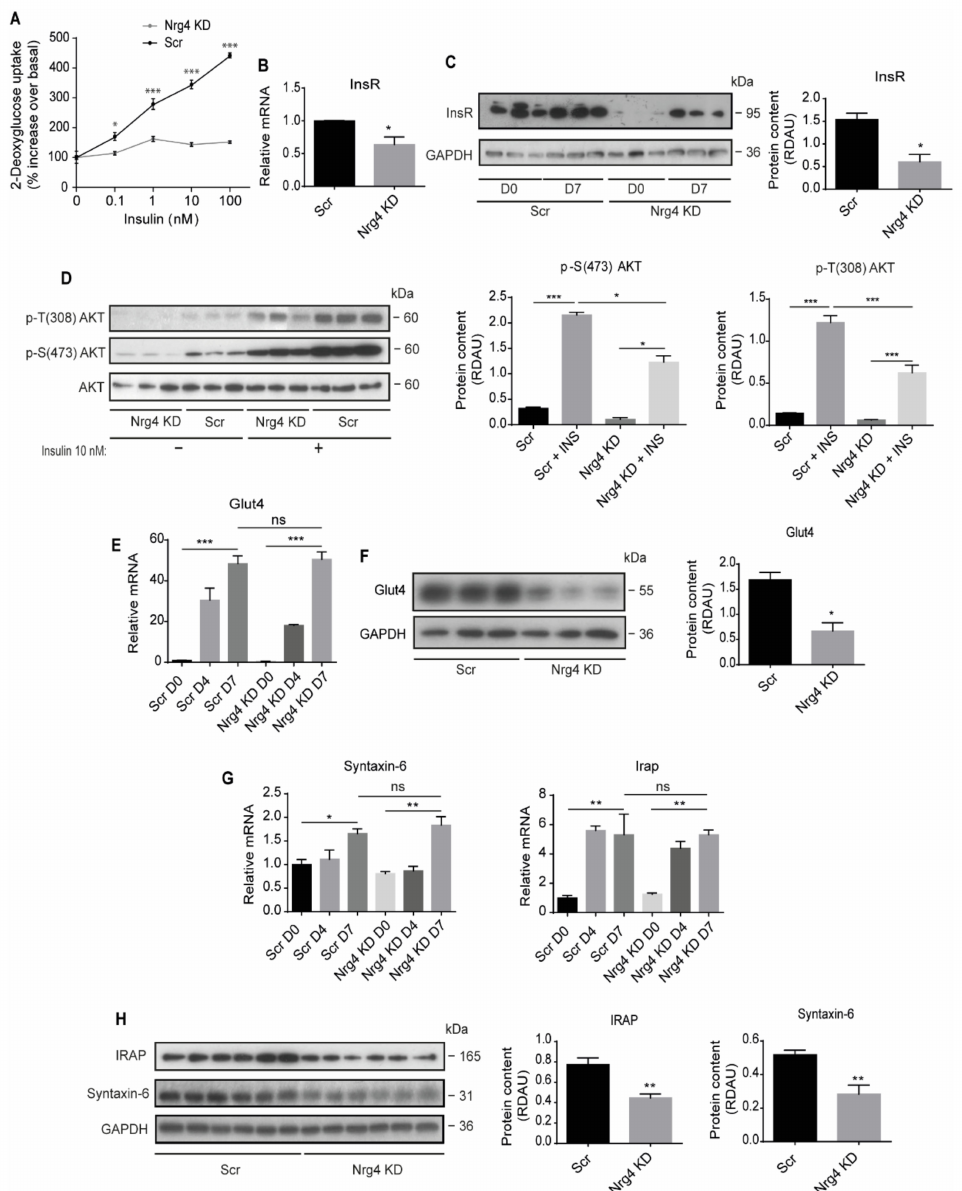
Figure 2. Nrg4 knockdown adipocytes are insulin resistant and show diminished insulin receptor expression and Glut4 protein content. ( A ) Concentration-response curve of the effect of insulin on 2- D -deoxyglucose uptake in Scr and Nrg4 KD adipocytes at day 7 (D7) of differentiation ( n = 3). Cells were starved without fetal bovine serum for 16 h and then incubated with different insulin concentrations for 30 min. 2- D -deoxyglucose uptake data were expressed as the % increase relative to basal values, in nmols/mg protein × 5 min. ( B ) Insulin receptor (InsR) expression in D7 Scr and Nrg4 KD adipocytes ( n = 3). Data were normalized to Scr adipocytes D7 expression. ( C ) Western blot bands of InsR β subunit in Scr and Nrg4 KD cells at D0 and D7 ( n = 3). The lower band of the InsR β subunit blot at D7 was quantified. ( D ) Western blot bands and quantification of phospho (p)-T(308)AKT and p-S(473)AKT in insulin-treated and non-treated Scr and Nrg4 KD adipocytes at D7 ( n = 3). Data were normalized to AKT protein content. ( E ) Glut4 expression in Scr and Nrg4 KD cells at D0, D4 and D7 ( n = 6). Data were normalized to Scr D0 preadipocyte expression. ( F ) Western blot bands and quantification for Glut4 in Scr and Nrg4 KD cells at D7 ( n = 3). ( G ) Syntaxin-6 and Insulin-regulated aminopeptidase (Irap) expression in Scr and Nrg4 KD cells at D0, D4 and D7 ( n = 3). Data were normalized to Scr D0 preadipocyte expression. ( H ) Western blot bands and quantification of IRAP and Syntaxin-6 in Scr and Nrg4 KD cells at D7 ( n = 6). Each lane in the blots represents an independent experiment. Quantification was normalized by the loading control, GAPDH, and expressed as relative densitometric arbitrary units (RDAU). Overall contrast and brightness of the western blot was adjusted to clarify the images. Data represent mean ± SEM. * p ≤ 0.05, ** p ≤ 0.01, *** p ≤ 0.001, ns (not